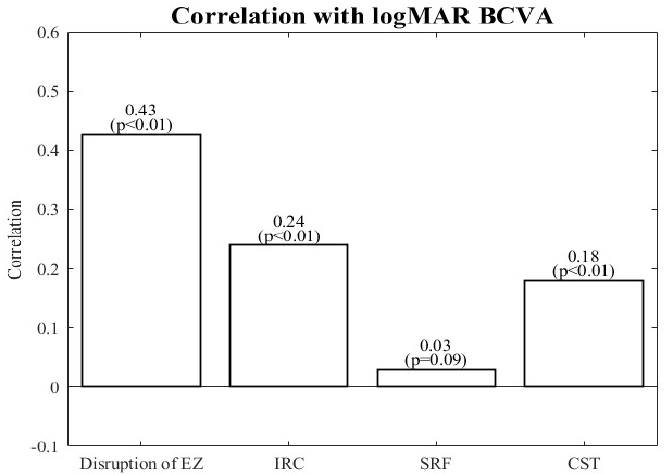
Figure 6. Correlation of retinal features with BCVA. BCVA: best corrected visual acuity; EZ: ellipsoid zone; IRC: intraretinal cystoid fluid; SRF: subretinal fluid; CST: central subfield thickness.